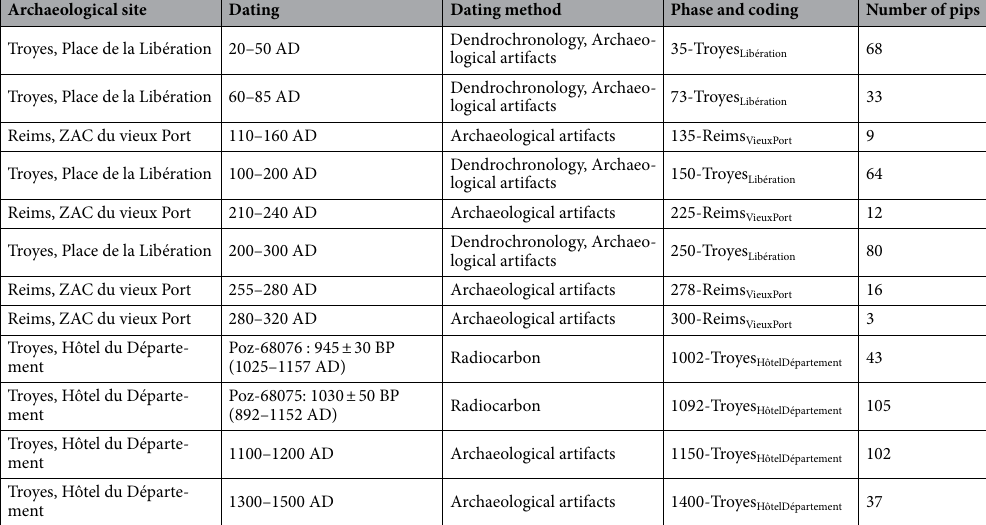
Table 2. Archaeological corpus. Sites and dates for material included in this